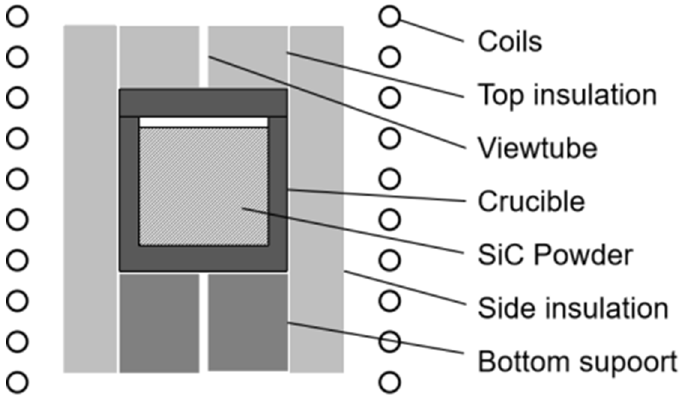
Figure 1. Schematic diagram of the